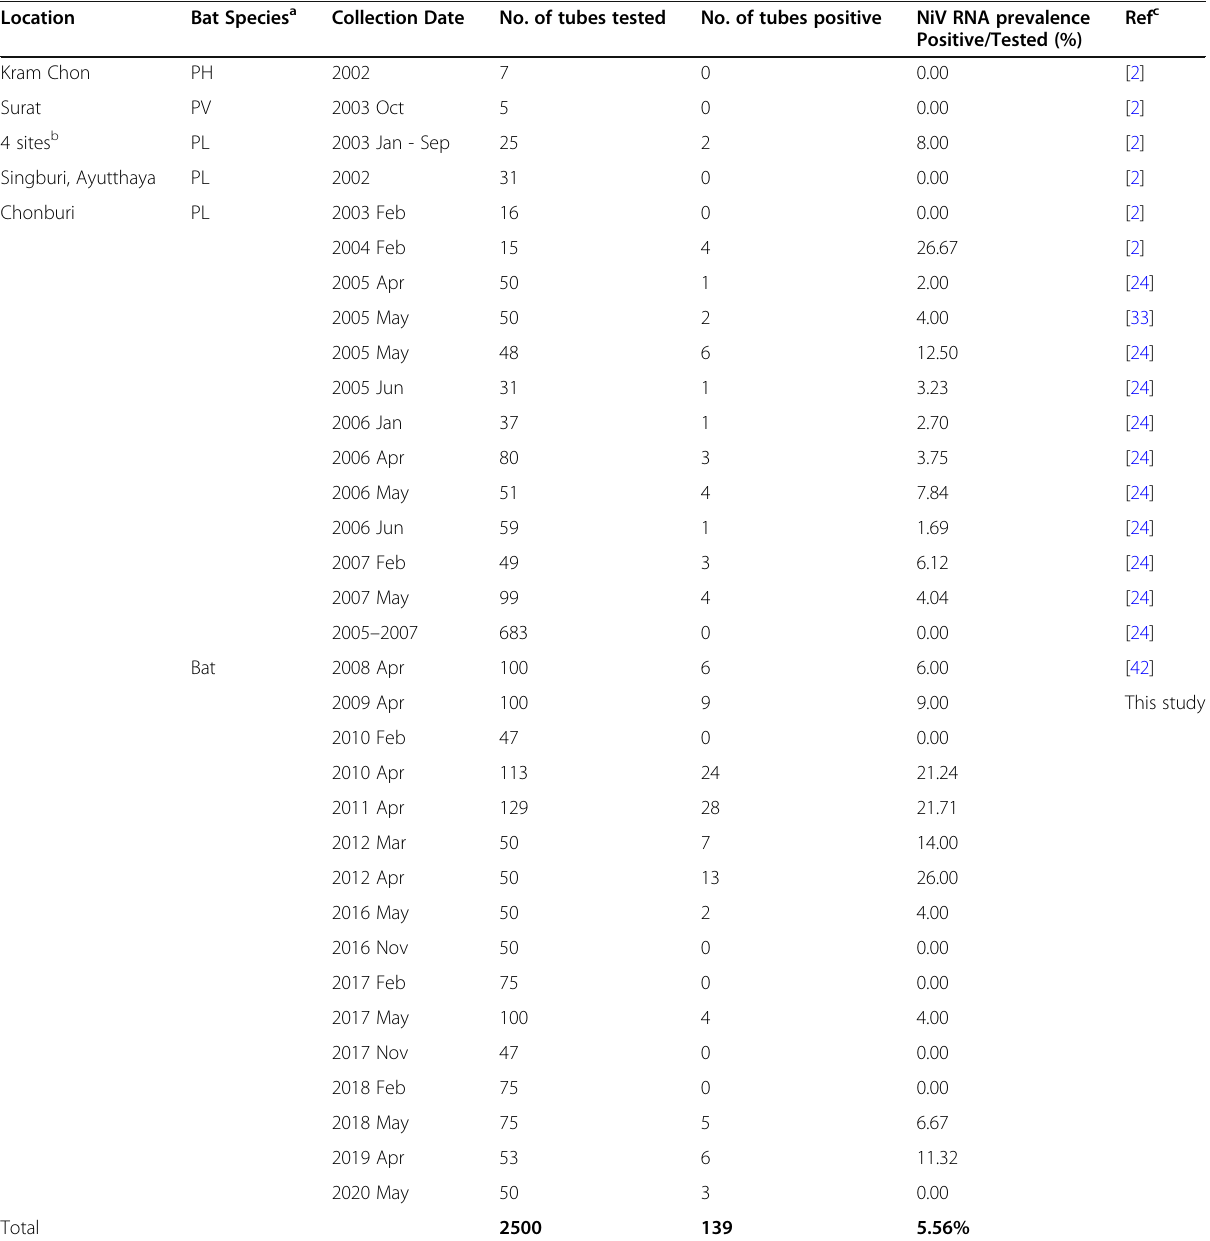
Table 2 Nested RT-PCR results detecting NiV RNA from pooled urine specimens from Pteropus bats collected during 2002 to 2020 in Thailand